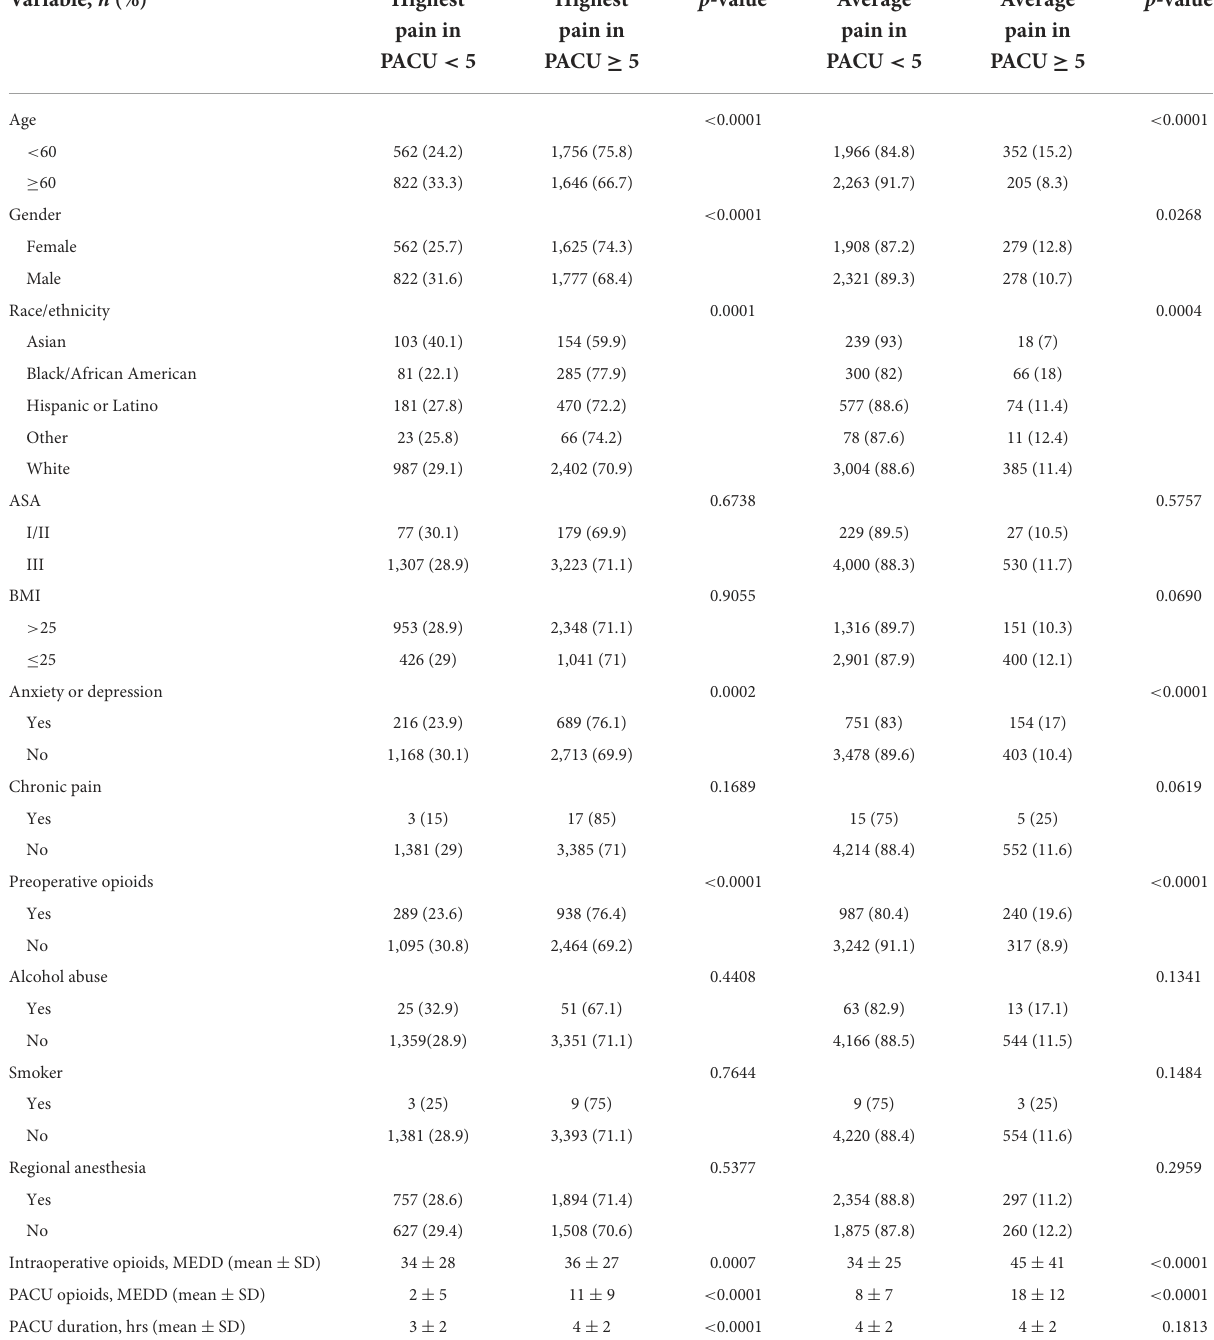
TABLE 4 Univariable analysis of the association between highest and average PACU pain scores and the perioperative characteristics of 4,791 adults undergoing open abdominal surgery. Variable, n